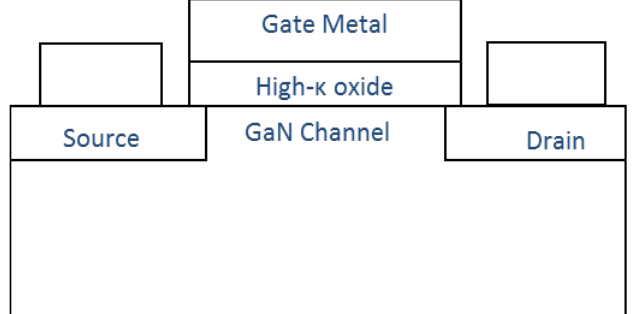
Figure 3. Structure of GaN based metal oxide semiconductor field effect